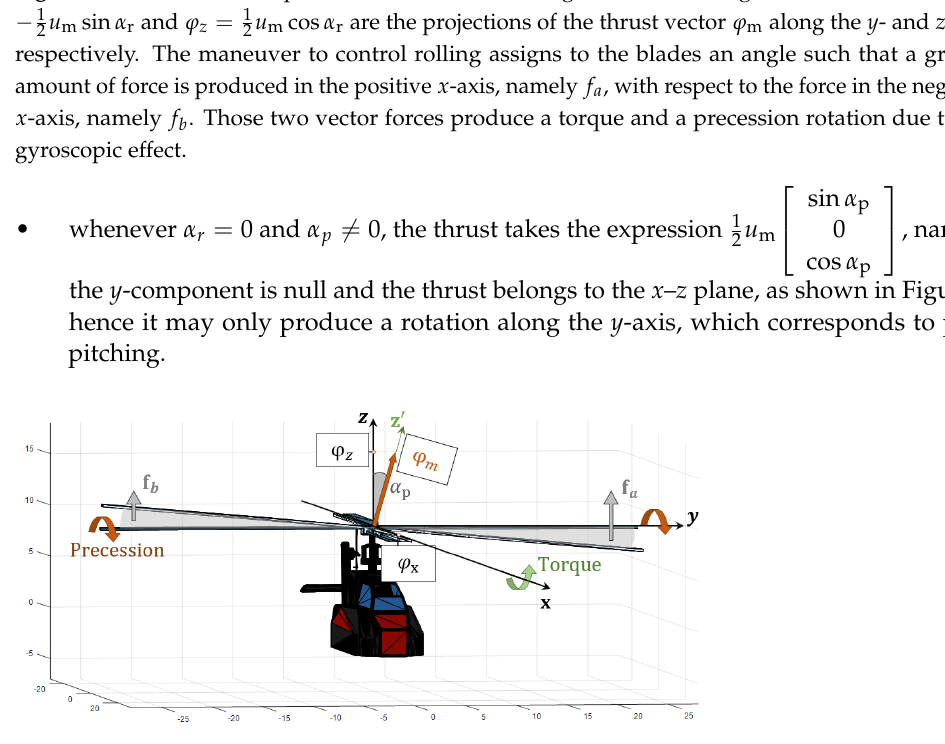
Figure 7. Illustration of a positive variation of the angle of attack along the y -axis, where u m sin α p and ϕ z = 1 u m cos α p are the projections of the main rotor thrust ϕ m to the x - ϕ x = 1 2 2 and z -axis, respectively. The maneuver to control the pitching assigns to the blades an angle such that a larger amount of force is produced in the positive y -axis, namely f a , with respect to the force along the negative y -axis, namely f b . Those two vector forces produce a mechanical torque and a precession of the